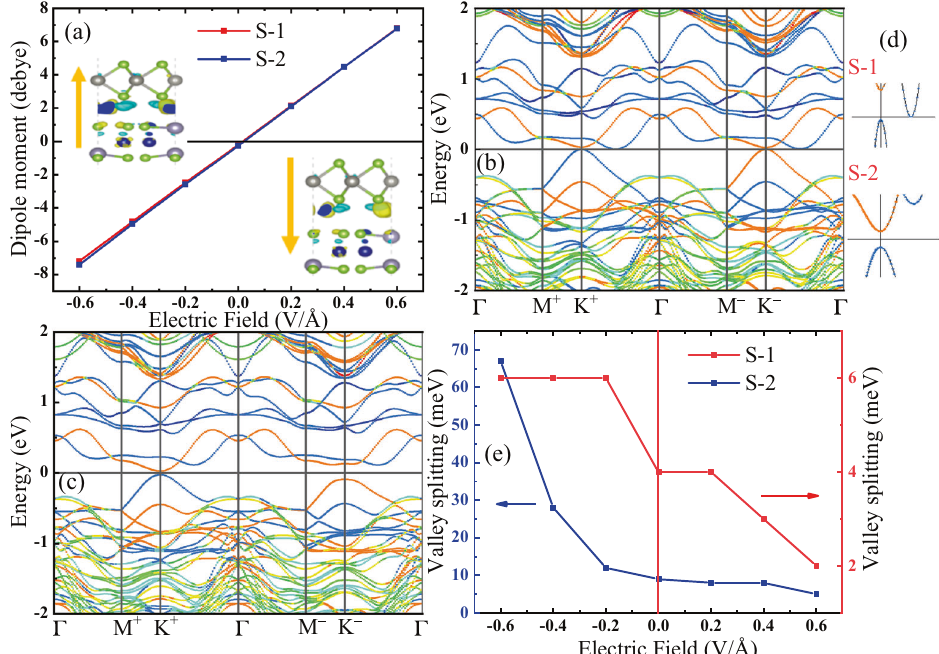
Fig. 5 External electric fi eld effect in S-1 and S-2 con fi gurations. a Electric fi led dependent dipole moment in both stackings. The inset is the charge density difference in S-1 stacking under − 0.4 V Å − 1 and + 0.4 V Å − 1 electric fi eld. The projected band structure including SOC in [001]